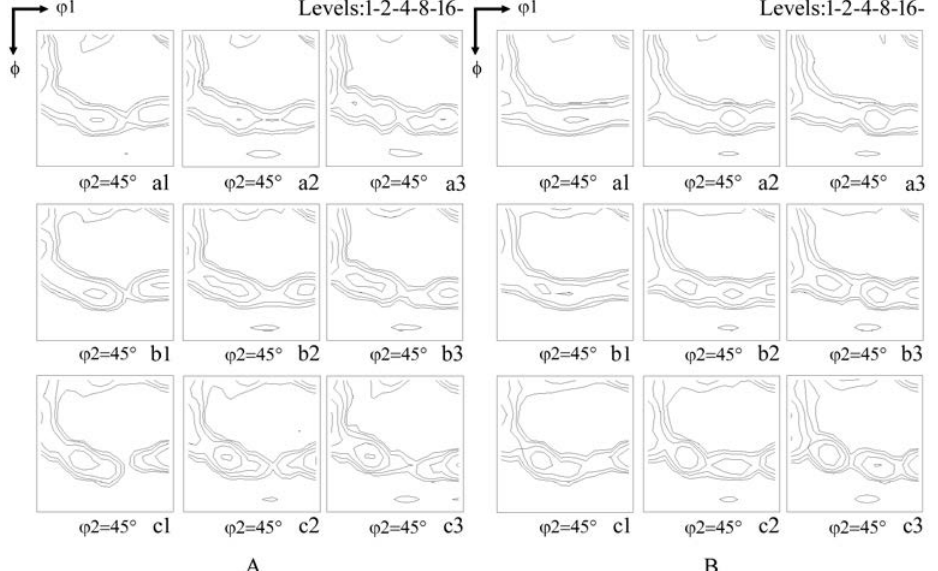
Figure 4. The effect of α 13 , α 23 and α 22 not higher than 0.08 on calculated texture when using α 12 = 0.2 and CRSS {110}<111> /CRSS {112}<111> = 0.95. ( A ) α 22 = 0: ( a1 ) α 13 = α 23 = 0; ( a2 ) α 13 = 0.04, α 23 = 0; ( a3 ) α 13 = 0.08,